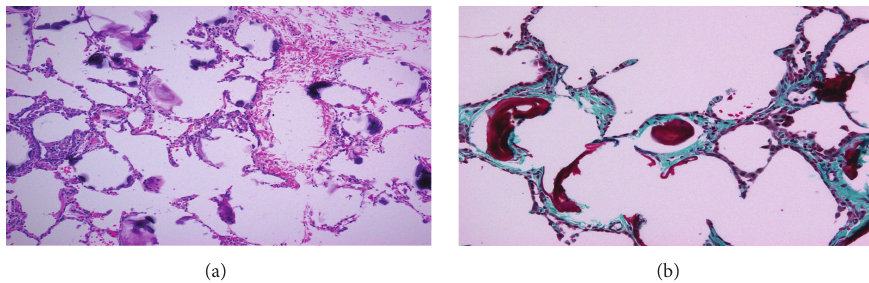
Figure 3: Histopathology. (a) Hematoxylin and eosin stain ( × 10). (b) Trichrome stain ( ×